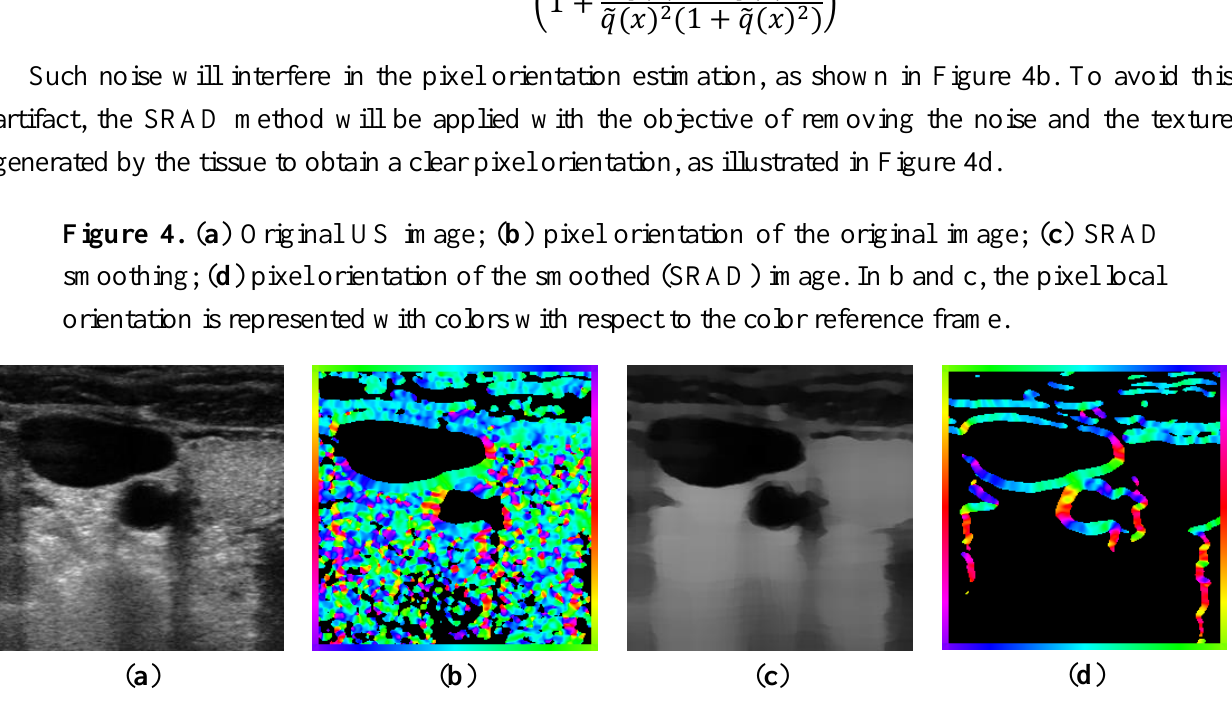
Figure 5. ( a ) US image smoothed with SRAD; ( b ) LIP-Sobel gradient; ( c ) non-max suppression applied to LIP-Sobel gradient estimation; ( d ) binary representation of the